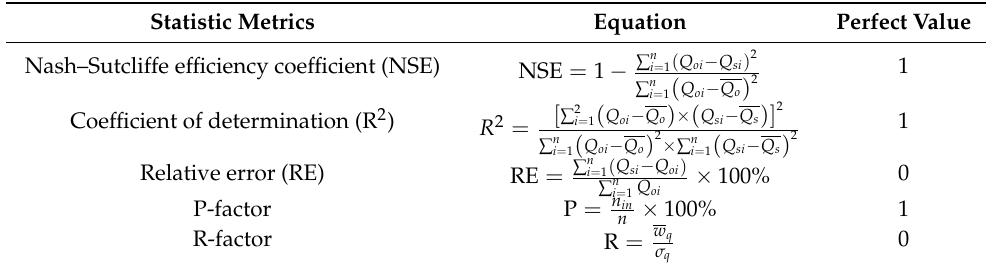
Table 1. List of the statistical metrics for assessing model performance and uncertainty. Statistic Metrics Equation Perfect